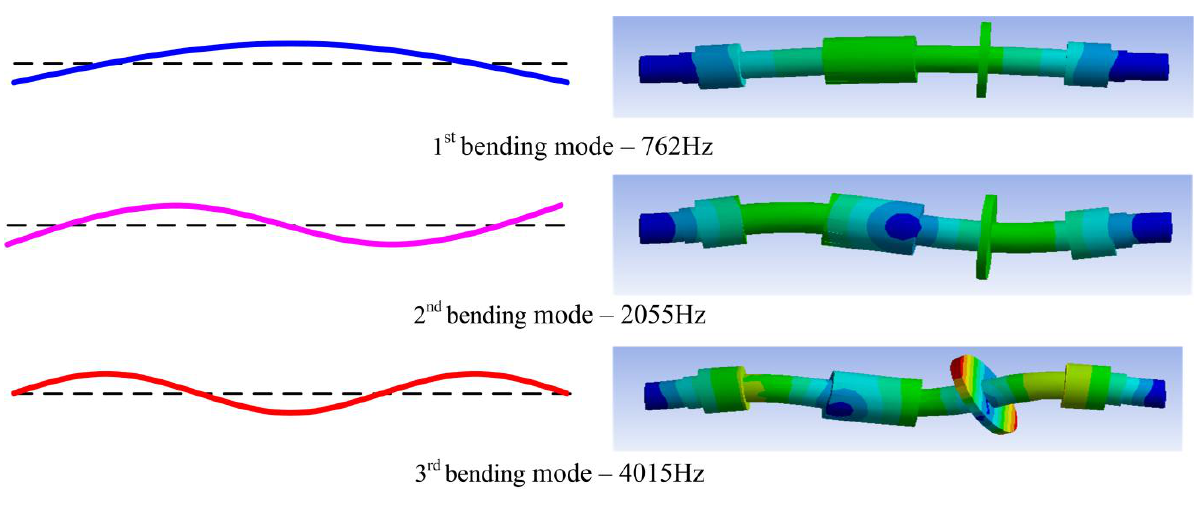
Figure 3. Shaft bending